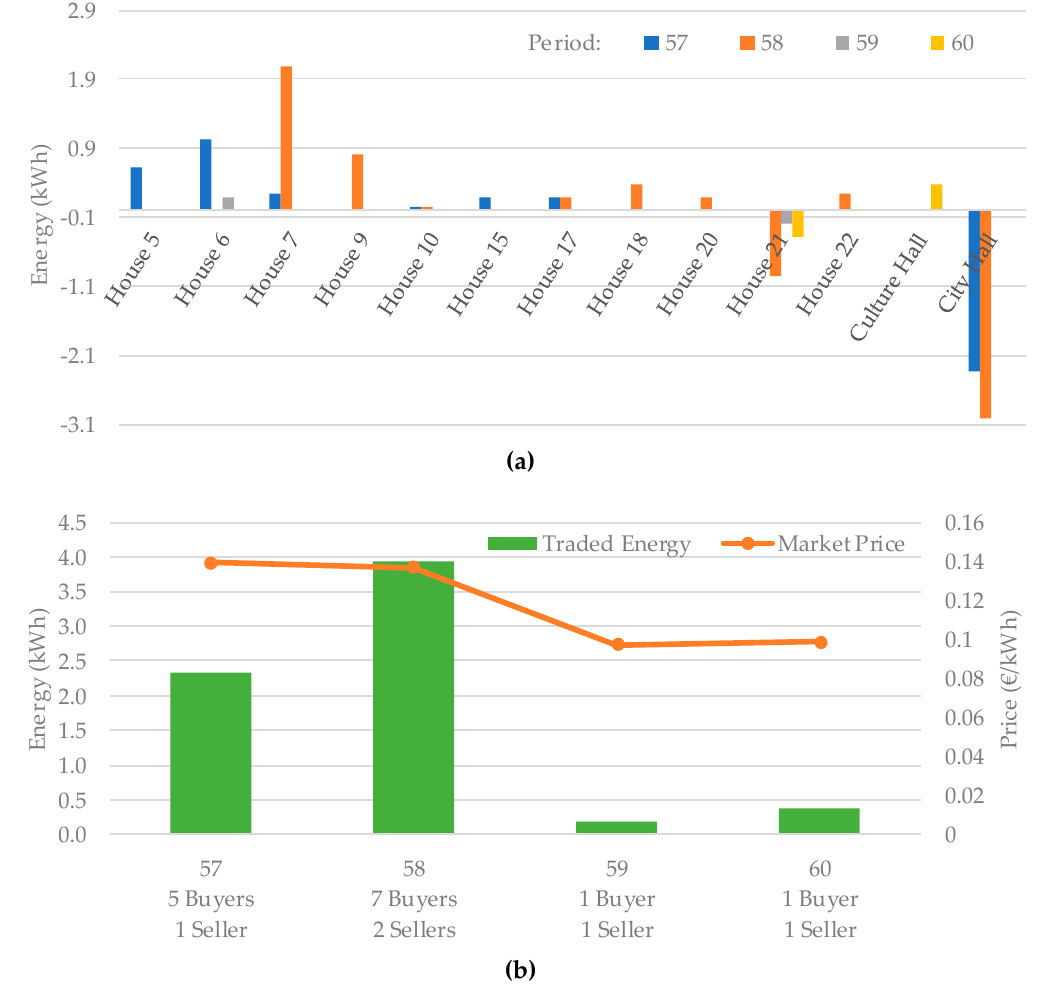
Figure 4. Local market players’ results: ( a ) players transacted energy per period; ( b ) period’s total traded energy, market price, and no. of dispatched players.